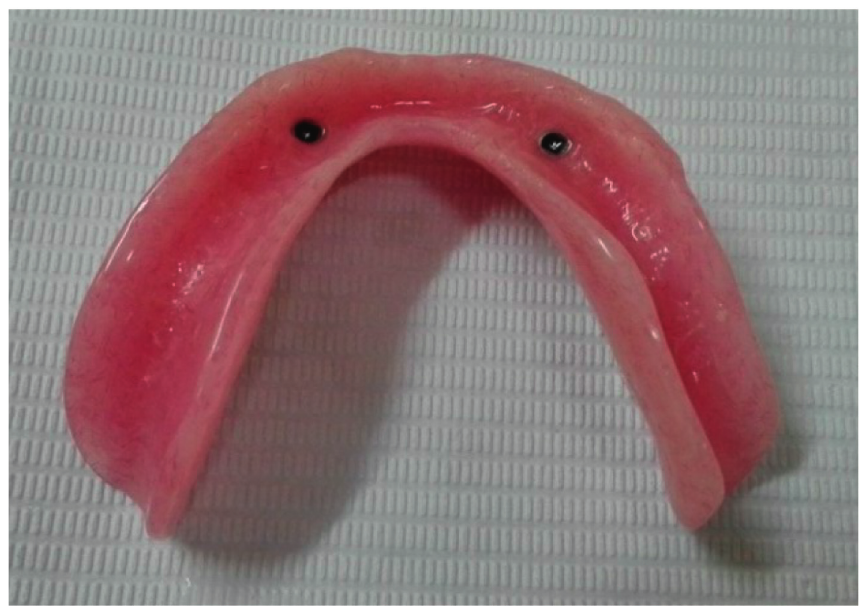
Figure 7: Fitting surface with picked up metal housing.